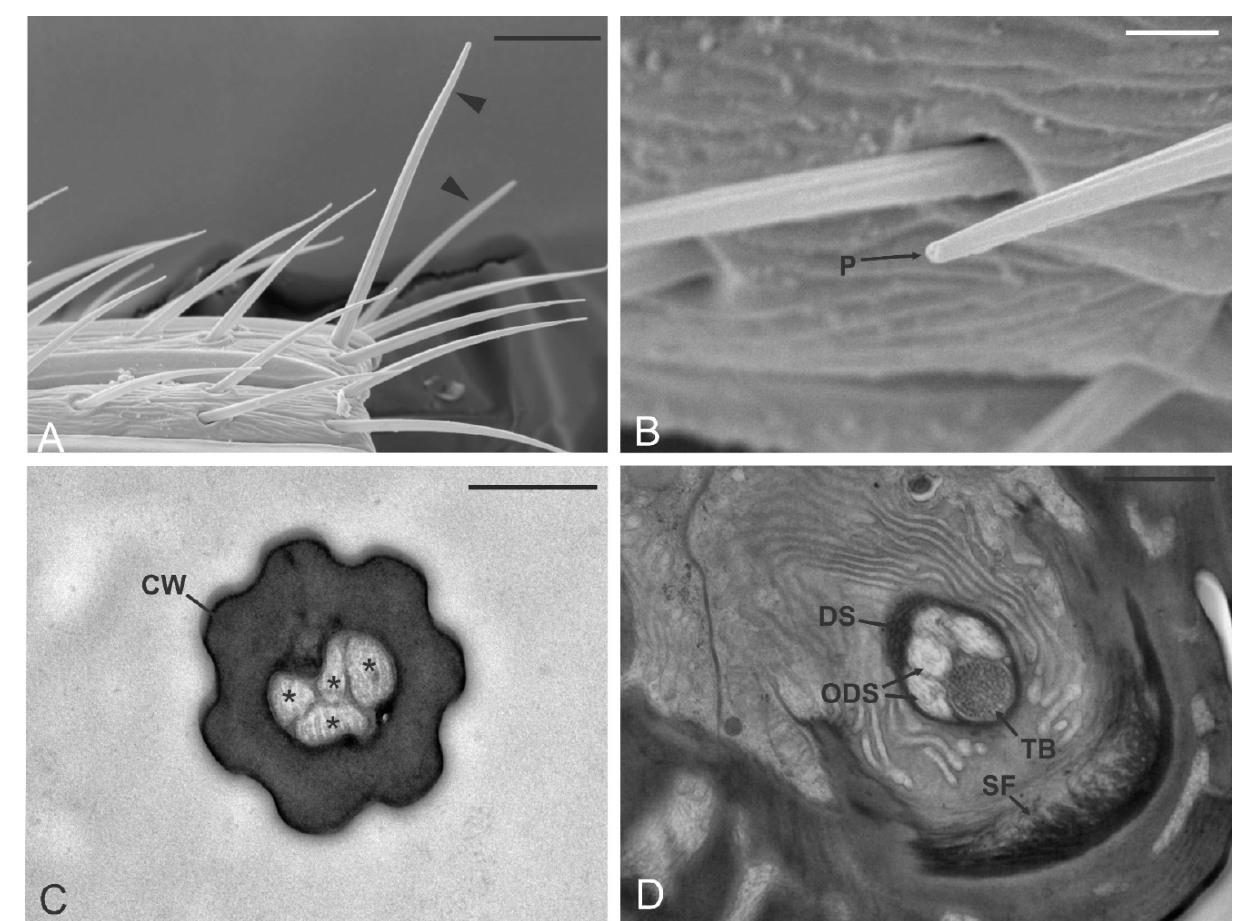
Figure 4. Sensilla chaetica (SCH). ( A , B ) SEM pictures showing the sensilla chaetica (arrowheads in ( A )) typically positioned at the distal margin of one of the antennomeres (in this case A10) and emerging from the rest of the antennal sensilla. In ( B ) a sensillum chaeticum with the apical pore (P) is highlighted. ( C , D ) TEM sections of the sensillum revealed the presence of a thick, aporous cuticular wall (CW) and a lumen occupied by four unbranched outer dendritic segments (*). Proximally, at the level of the sensillum socket, sensilla chaetica present suspension fibers (SF) around the socket. The fascicle of sensory neurons is enclosed by a single dendrite sheath (DS) and is made up of the four abovementioned ODS plus a fifth sensory neuron that develops in a tubular body (TB). Bar scale: ( A ), 10 µm; ( B ), 2 µm; ( C ), 0.5 µm; ( D ), 1 µm.